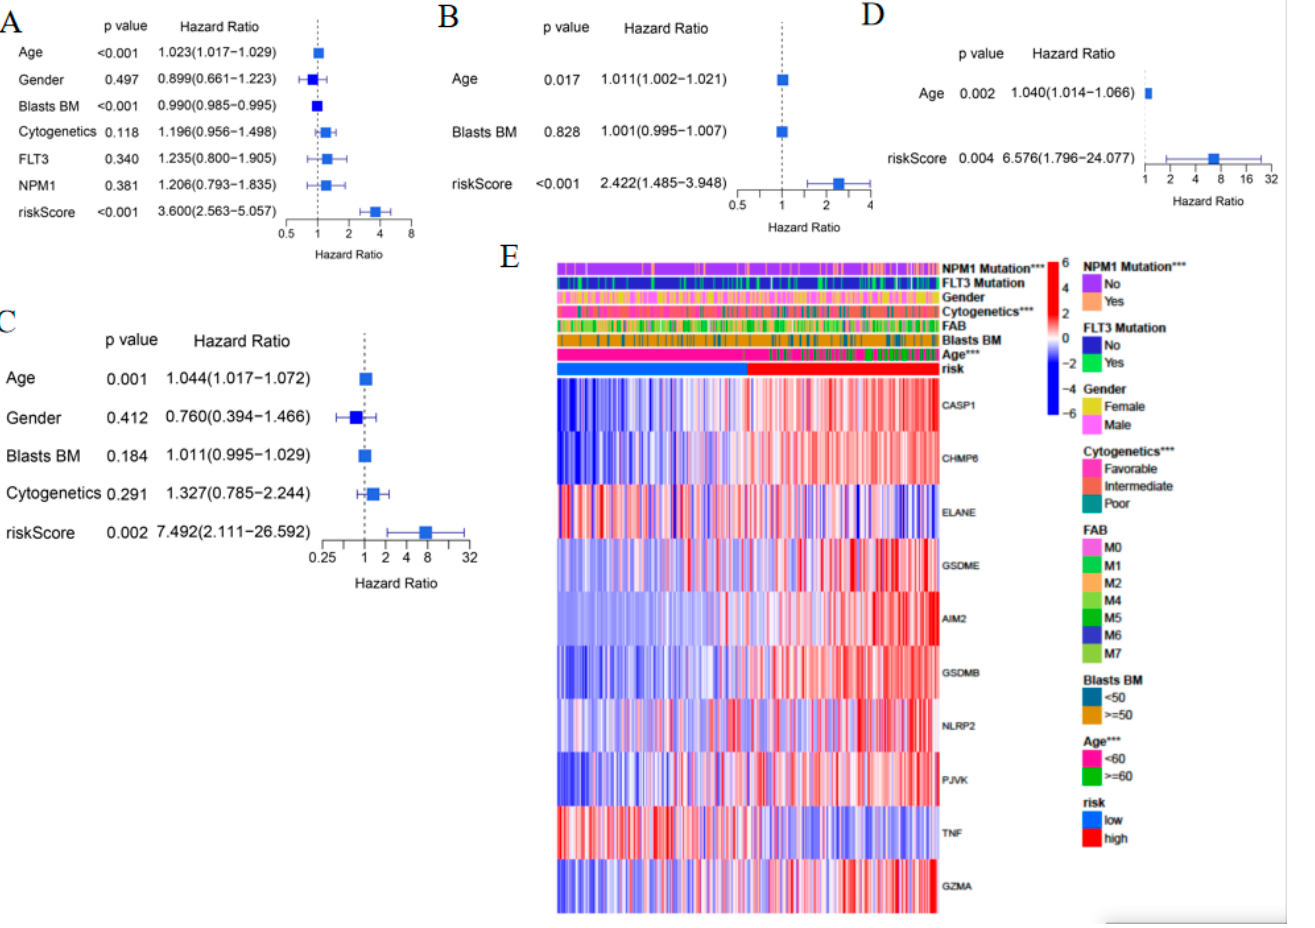
Figure 5. Univariate and multivariate Cox regression analyses of the risk score and clinical features. ( A , C ) Univariate analysis of the TCGA-TARGET cohort ( A ) and GEO cohort ( C ) (Cytogenetics: favorable, intermediate, poor; Blasts BM: blasts percentage in the bone marrow). ( B , D ) Multivariate analysis of the TCGA-TARGET cohort ( C ) and the GEO cohort ( D ). ( E ) Heatmap (blue: low expression; red: high expression) of clinical characteristics in the TCGA-TARGET cohort between the high-risk and low-risk groups (*** p < 0.001).